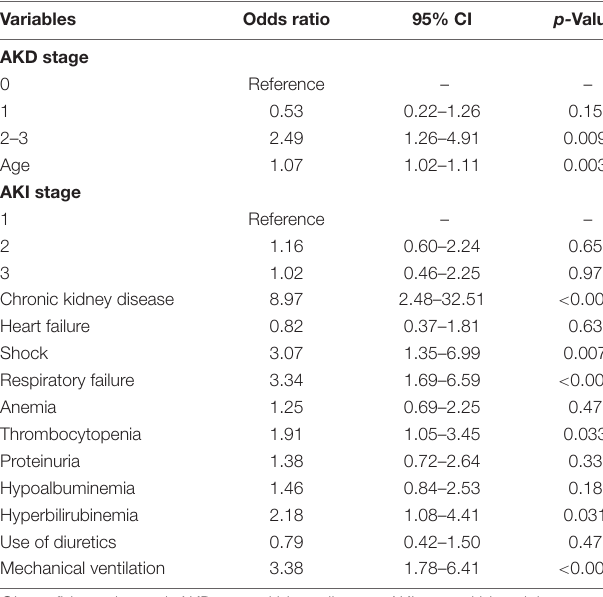
TABLE 3 | Multivariable logistic analysis for predictors of Major Adverse Kidney Events within 30 days.